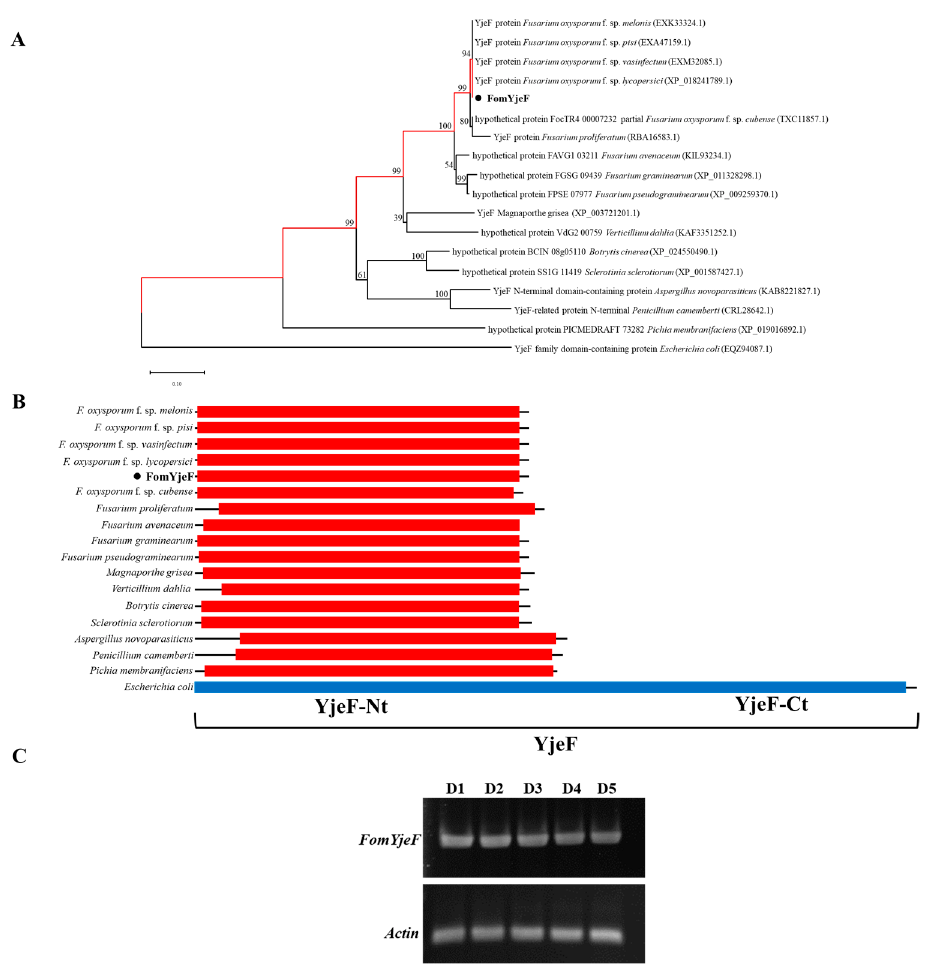
Figure 1. Sequence analysis of FomYjeF. ( A ) The phylogenetic tree was constructed based on amino acid sequences of FomYjeF and other fungi and bacteria using the neighbor-joining method with 1000 bootstrap replicates. The numbers at the nodes of the phylograms denote the bootstrap confidence values. ( B ) Phylogenetic analysis of conserved domains was structured based on the fungi and bacteria of the phylogenetic tree. ( C ) The everyday expression level of FomYjeF was determined by RT-PCR. Actin was a reference gene. D1–D5 represented the 5 day transcription level of FomYje F in SD-1. The FomYjeF-IN-F/R and Actin-F/R primer sets were